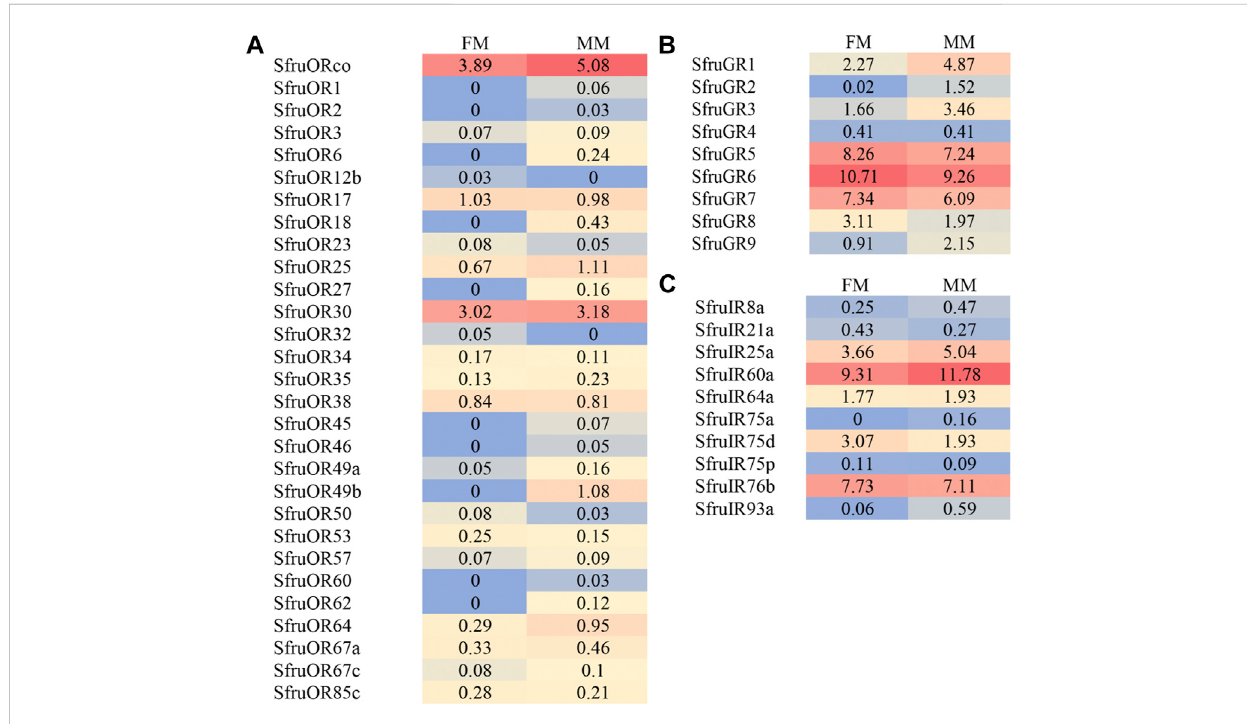
FIGURE 4 Heat-plot of TPM values for candidate chemoreceptors in female mouthpart (FM) and male mouthparts (MM). (A) . SfruORs , (B) . SfruGRs , (C) . SfruGRs . The TPM value of each OR gene is indicated in each